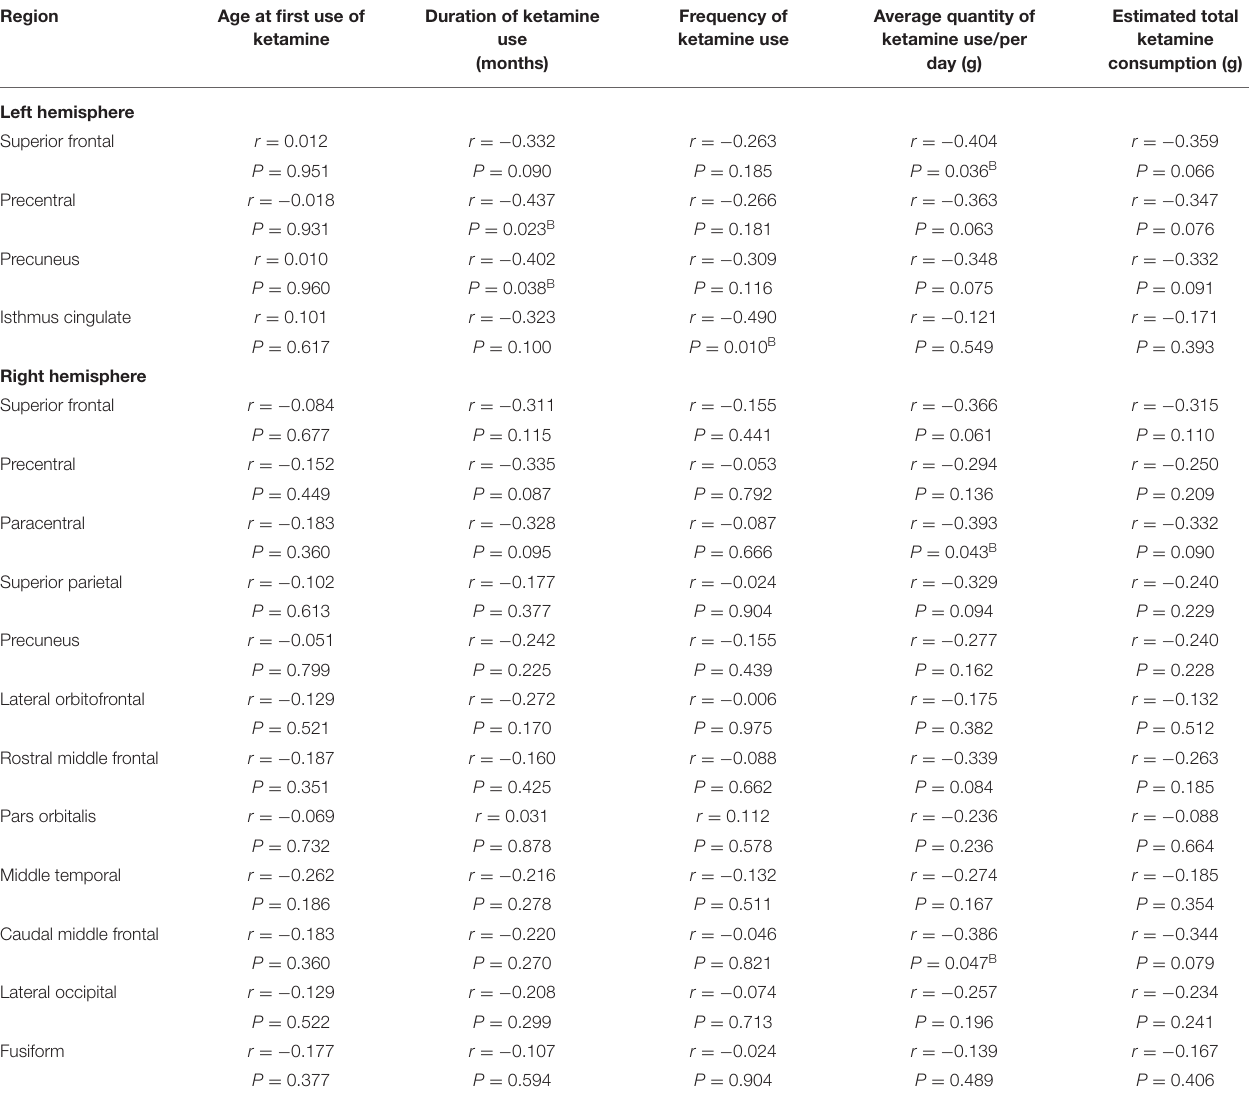
TABLE 4 | Correlation between changes in cortical thickness and clinical associated characteristics in chronic ketamine users. Region Age at first use of